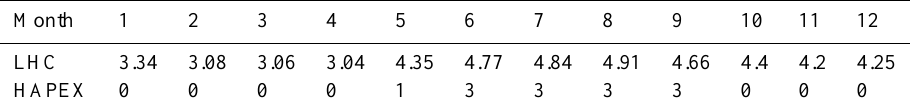
Table 2. Monthly leaf area index values (in m 2 m − 2 ) for LHC in 2010 and HAPEX in 1986. LHC data were obtained from Wu (2011); HAPEX data were obtained from Goutorbe et al. (1989).